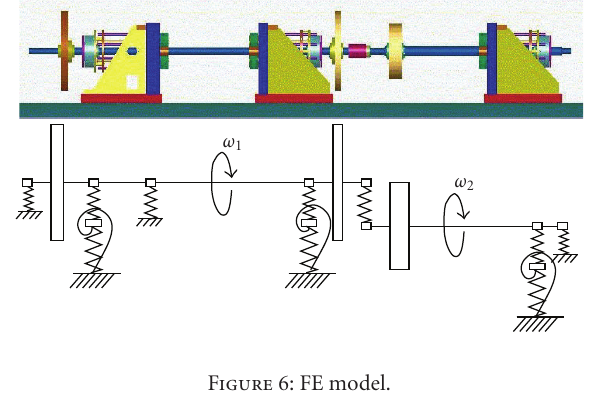
Figure 6: FE model.